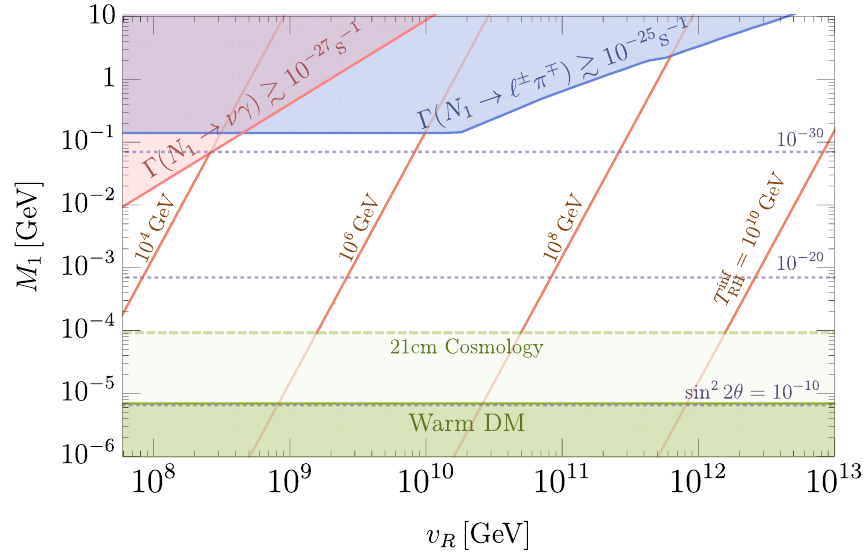
Figure 3 . The parameter space for N 1 DM produced by freeze-in. The observed relic abundance occurs in the unshaded region for values of T inf shown by the red contours. Constraints from small RH scale structure are shown in green , with projections from future probes of small scale structure using the 21 cm line in dashed green . In the blue region N 1 decays too rapidly via W R to ‘ ± π ∓ and in the pink region N 1 decays too rapidly via W R − W L mixing to νγ . The horizontal dashed blue lines show the limit (3.6) on the mixing angle of N 1 with active